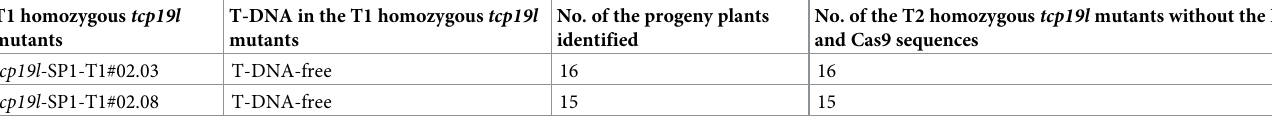
No. of the progeny plants No. of the T2 homozygous tcp19l mutants without the BAR identified and Cas9 sequences